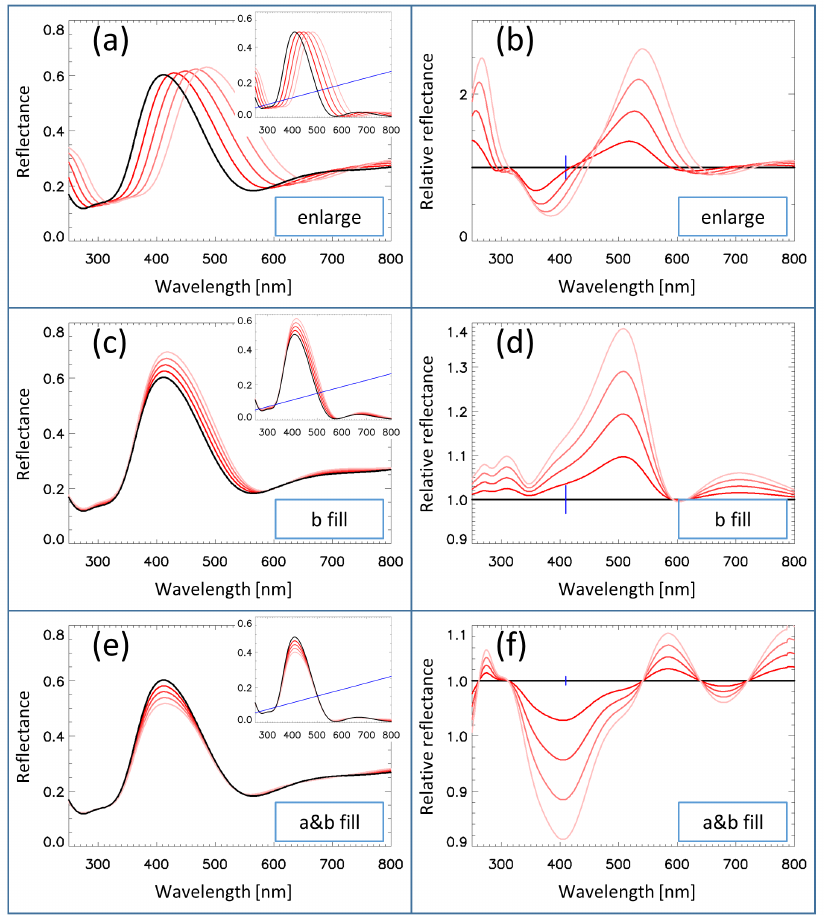
Figure 6. Effect of the gradual changing of different simulation parameters on the calculated dorsal reflectance spectrum of the Albulina metallica butterfly. ( Left ) Simulated reflectance spectra for the whole wing. (Left insets) Simulated reflectance spectra for single scales. The blue line shows the background added to these spectral curves in order to model the whole wing spectra. ( Right ) Simulated relative reflectance spectra for the whole wing. The small vertical bars denote the position of the peak wavelength of the reflectance. ( a , b ) Isotropic enlargement of the structure by 4%, 8%, 12%, and 16%. ( c , d ) Effect of the c B parameter for 0.2, 0.4, 0.6, and 0.8 values. ( e , f ) Effect of the c AB parameter for 0.05, 0.10, 0.15, and 0.20 values. Note the identical vertical scales on Subfigures ( a , c , e ) and the different vertical scales on Subfigures ( b , d , f